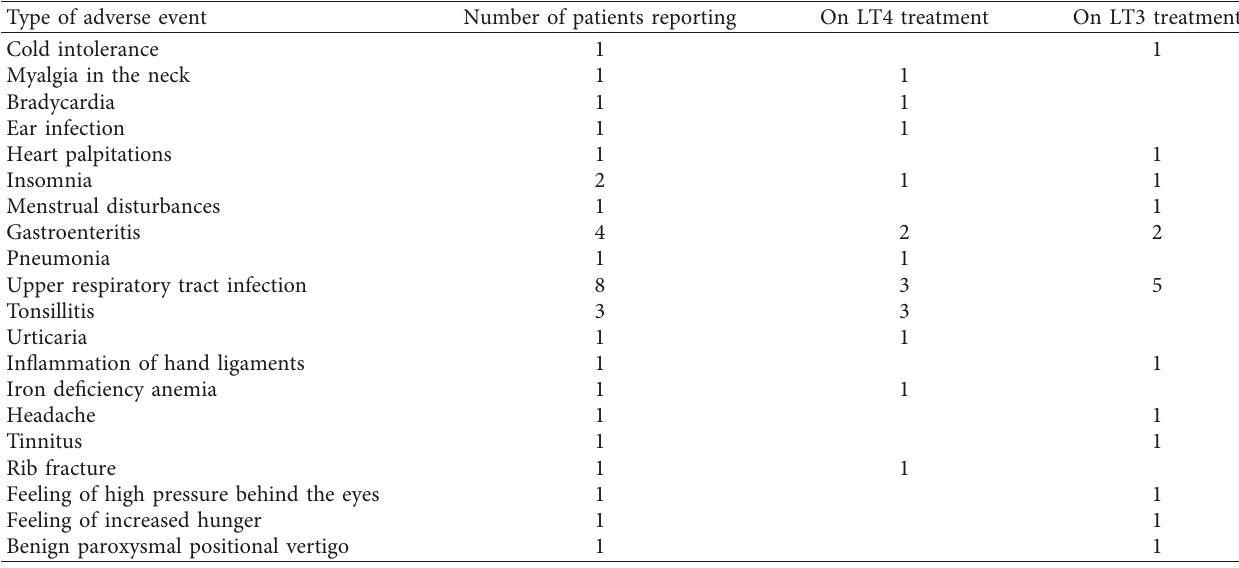
Table 4: Number and specification of adverse events in the two treatment